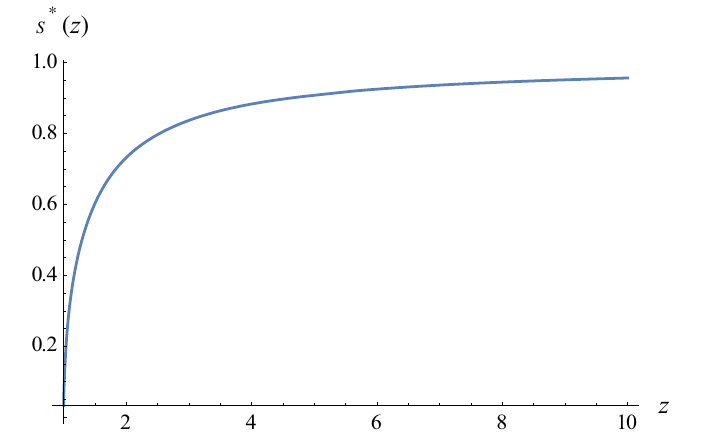
Fig. 3 The buyer group size maximizing the per-member consumer surplus as a function of parameter